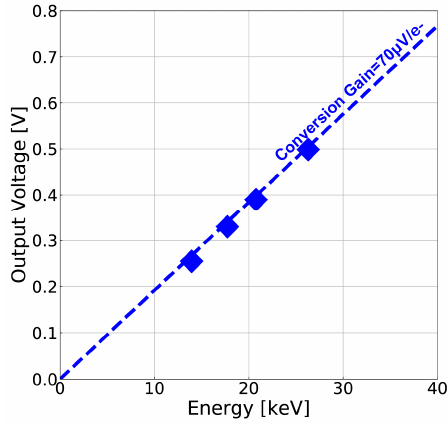
Figure 19. Confirmation of conversion gain with the measured X-ray spectra of 241 Am.